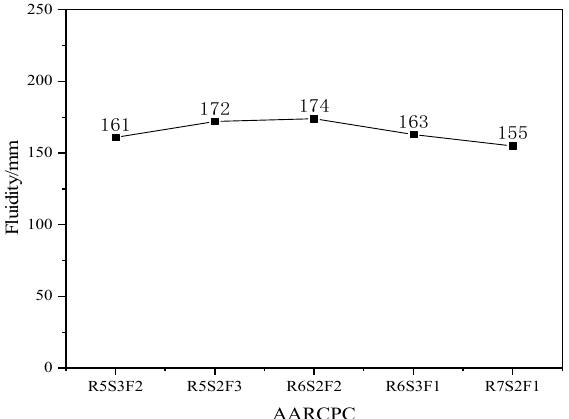
Figure 7. Fluidity of AARCPC with different composite fly ash and slag content.